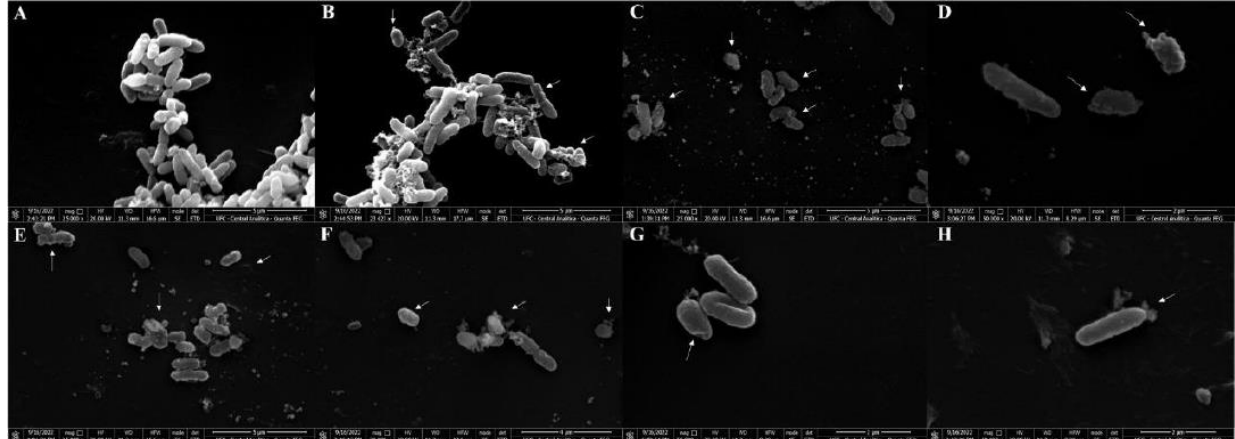
Figure 4. Scanning electron microscope of K. pneumoniae cells treated with Mo -CBP 3 -PepI. ( A ) control K. pneumonia cells treated with DMSO-NaCl solution. ( B – H ) K. pneumoniae cells treated with Mo -CBP 3 - PepI 31.26 µg mL −1 .